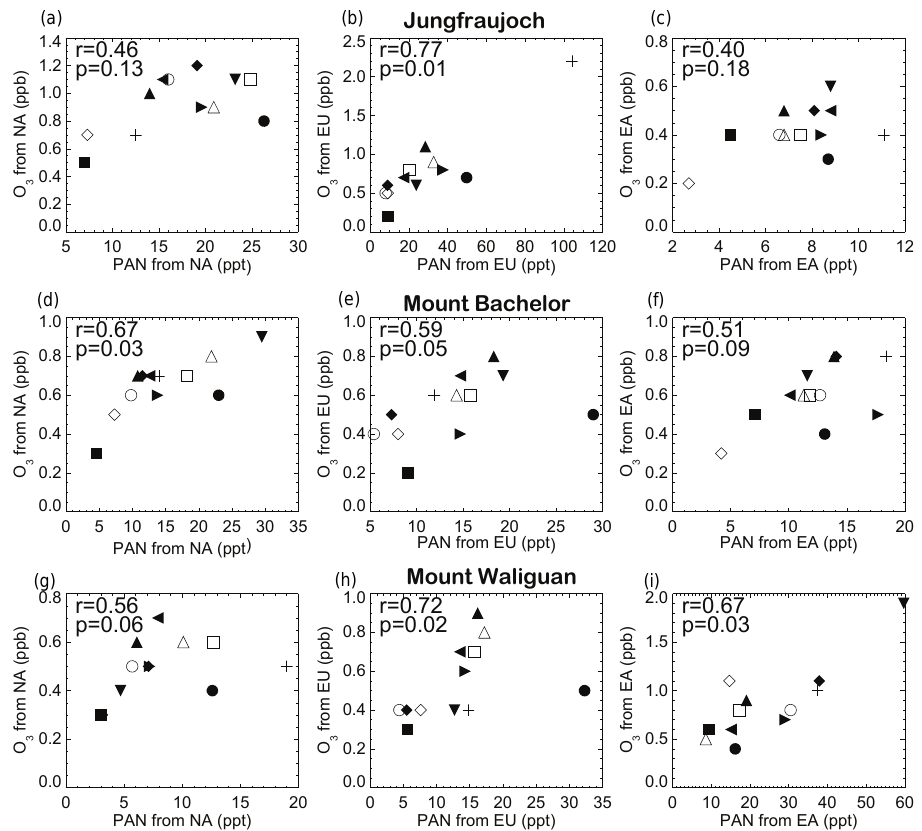
Figure 7. SRRs for O 3 versus PAN at Jungfraujoch (a, b, c) , Mount Bachelor (d, e, f) , and Mount Waliguan (g, h, i) , obtained by subtracting the SR6XX from the SR1 simulations (Table 2) available from 12 models, for which XX denotes the NA (a, d, g) , EU (b, e, h) , or EA (c, f, i) source region. Each model thus contributes one point (symbols defined in Table 1) in each panel. Spearman’s (rank) correlation coefficient and p values are also